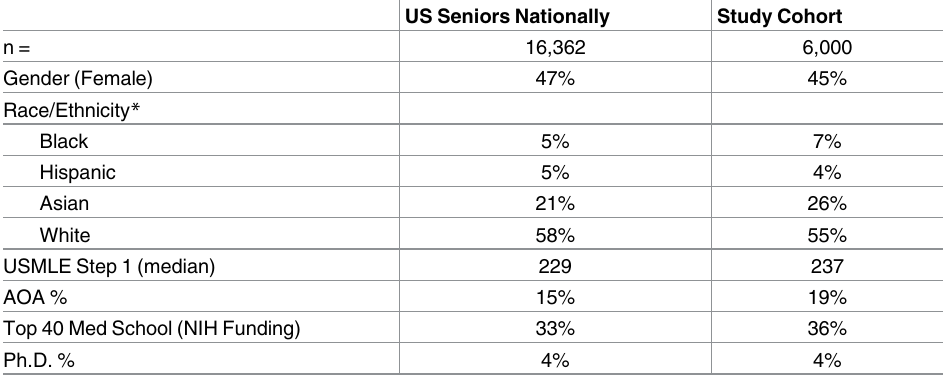
Table 1. Characteristics of US medical school seniors nationally and study population.